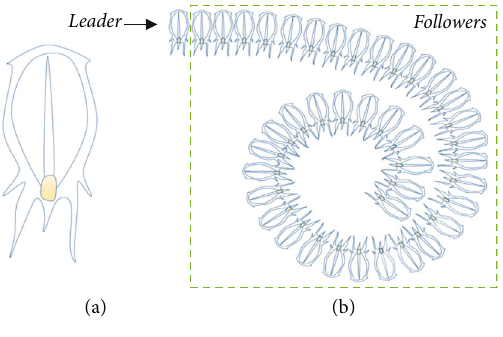
Figure 1: Salp (a). Salp chain